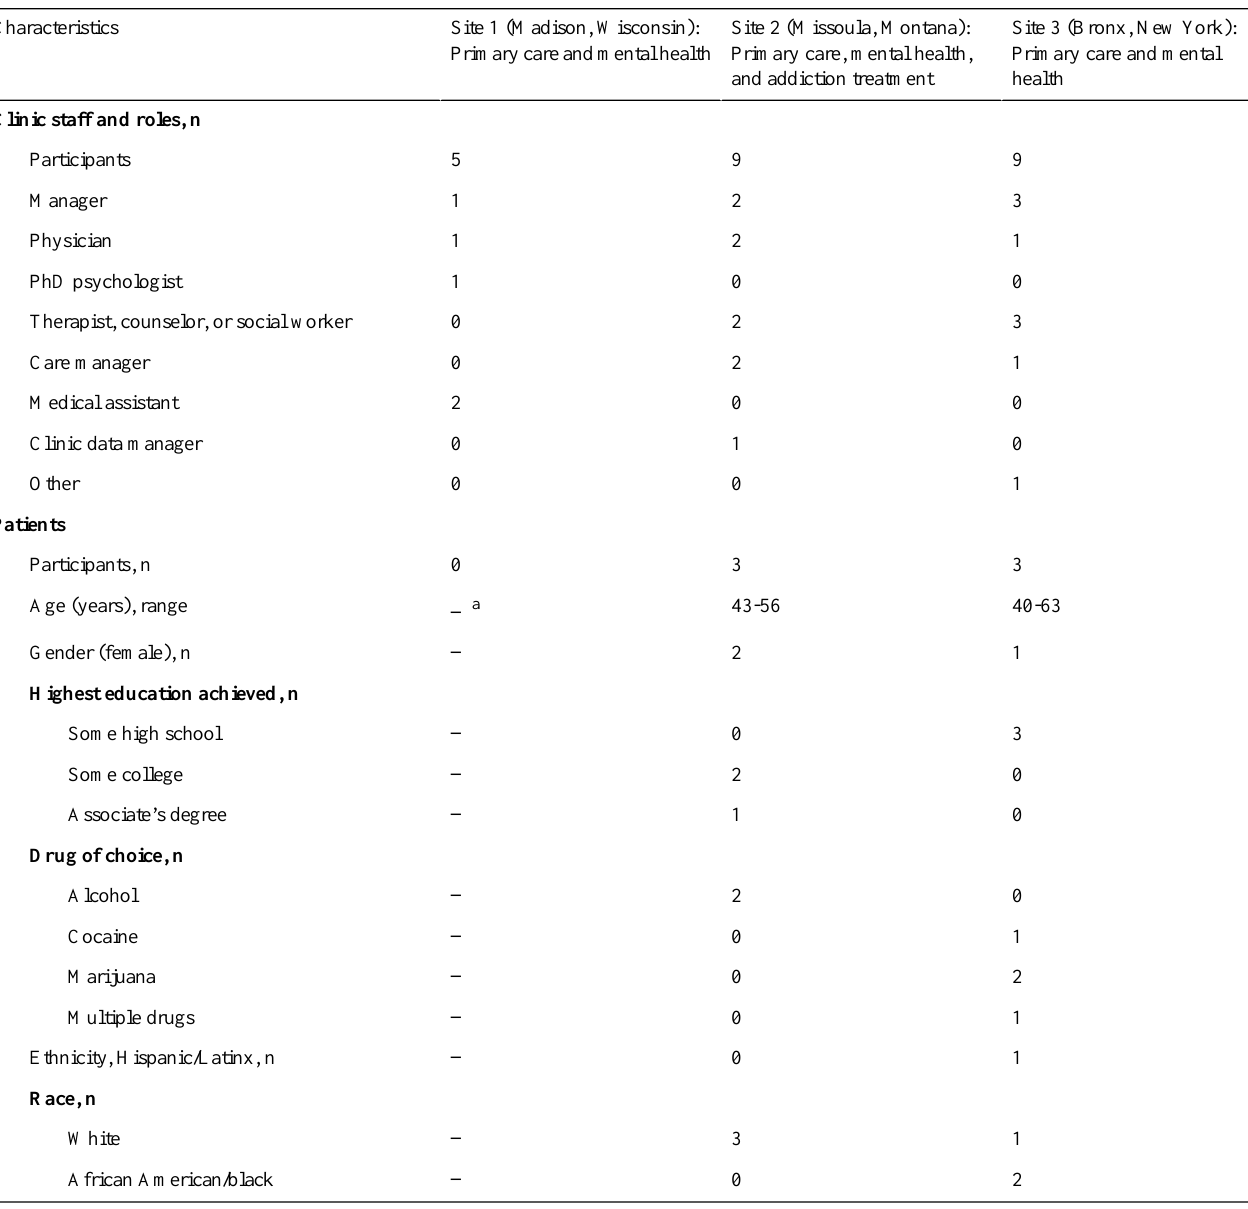
Table 1. Baseline characteristics of participating clinics, clinic staff, and patients.